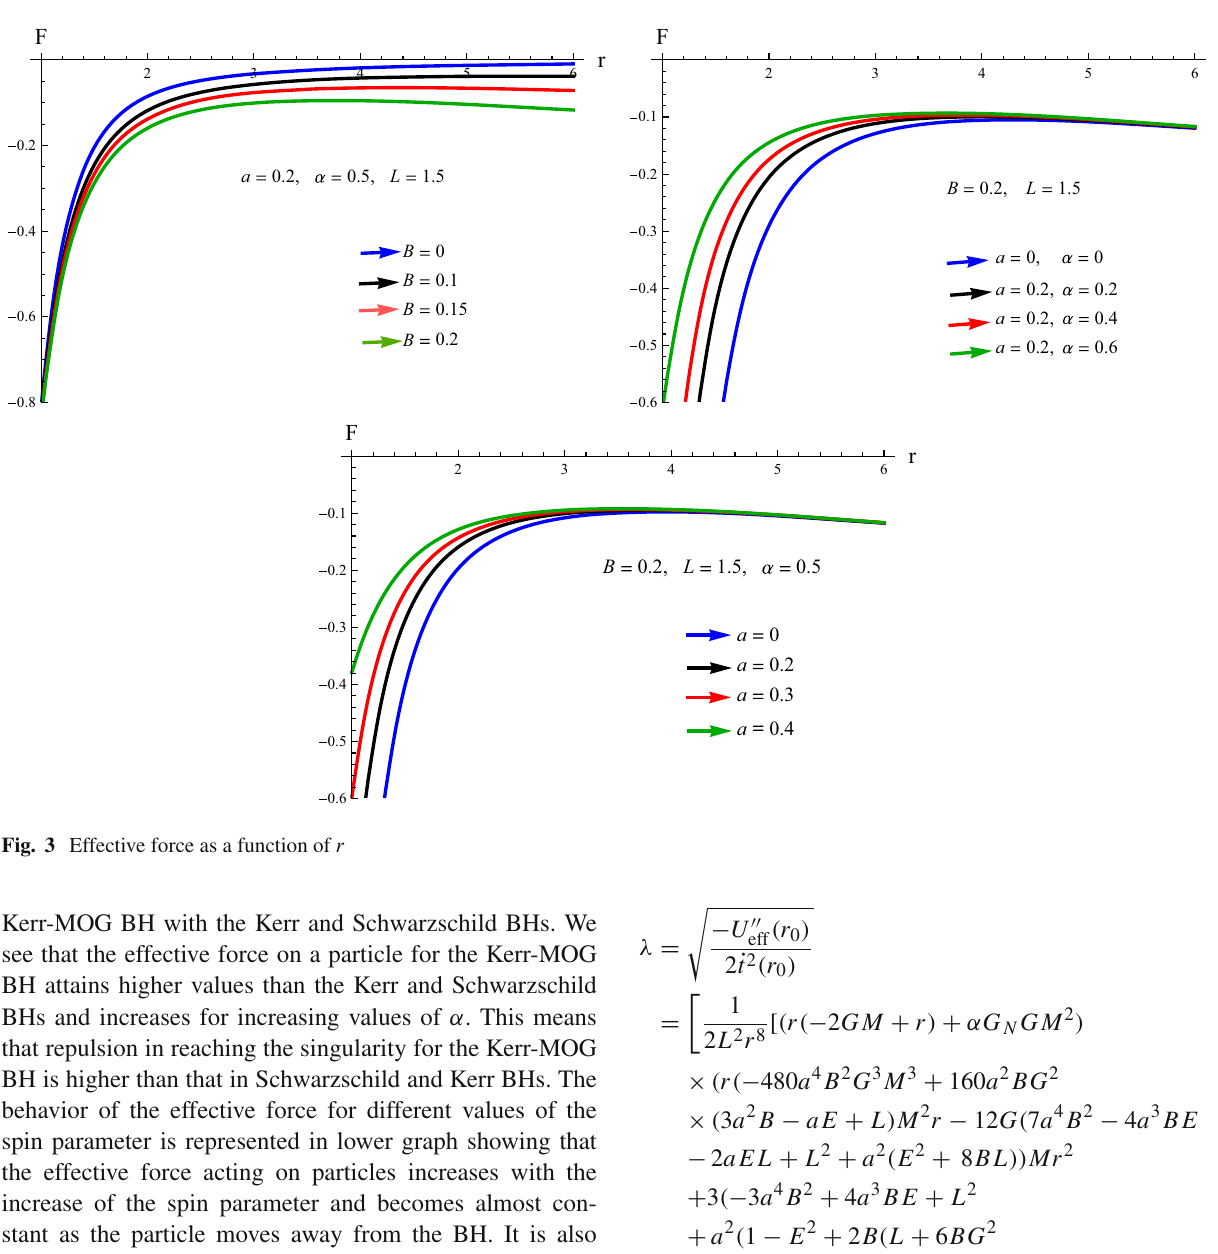
Fig. 3 Effective force as a function of r